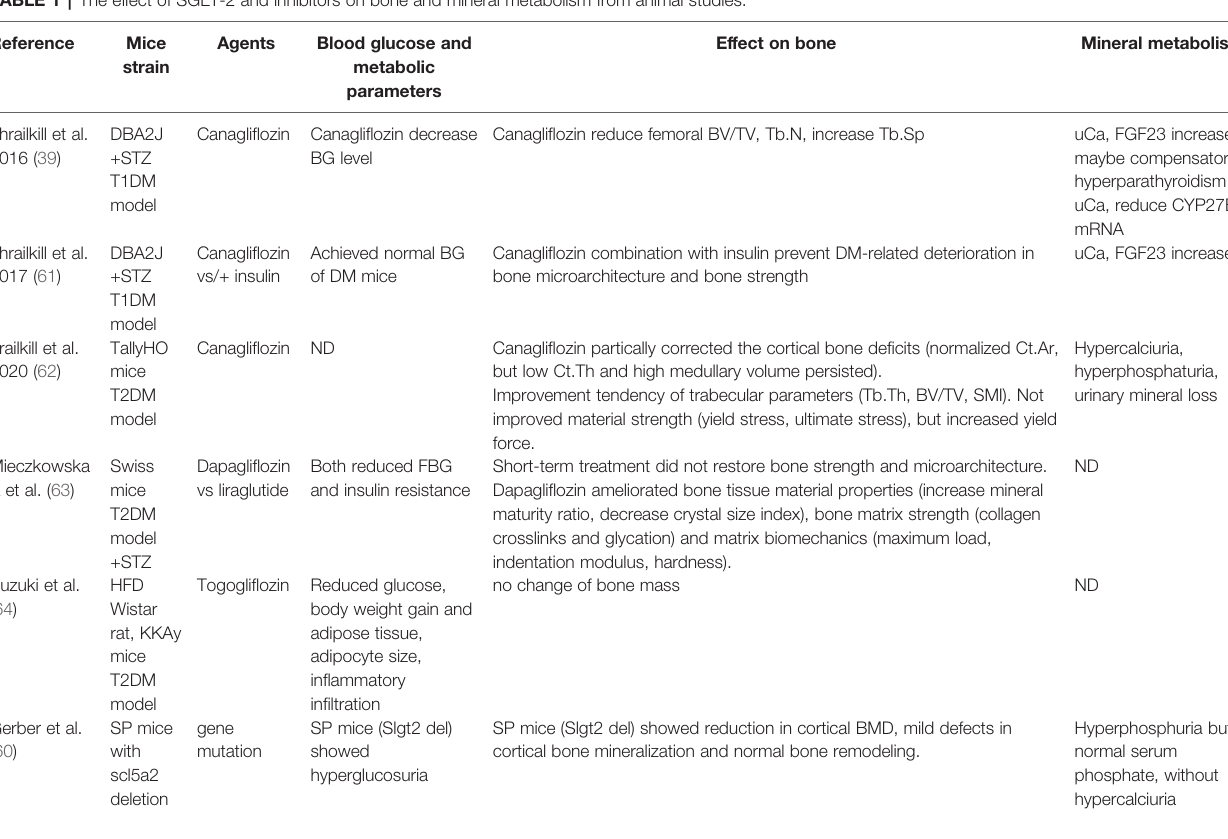
TABLE 1 | The effect of SGLT-2 and inhibitors on bone and mineral metabolism from animal